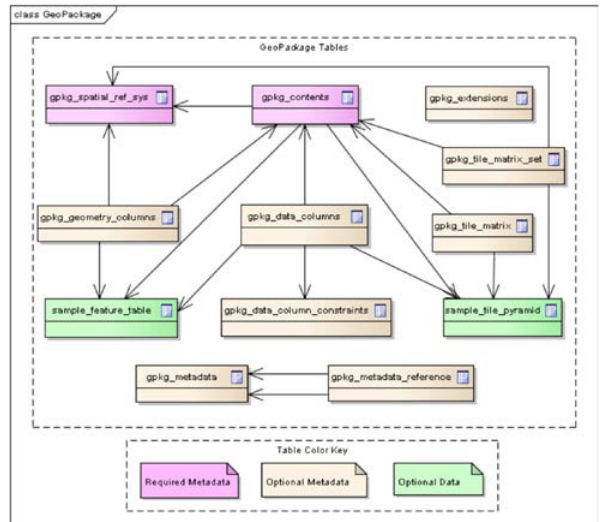
Figure 1. GeoPackage tables overview.(Source: OGC GeoPack- age Encoding Standard)